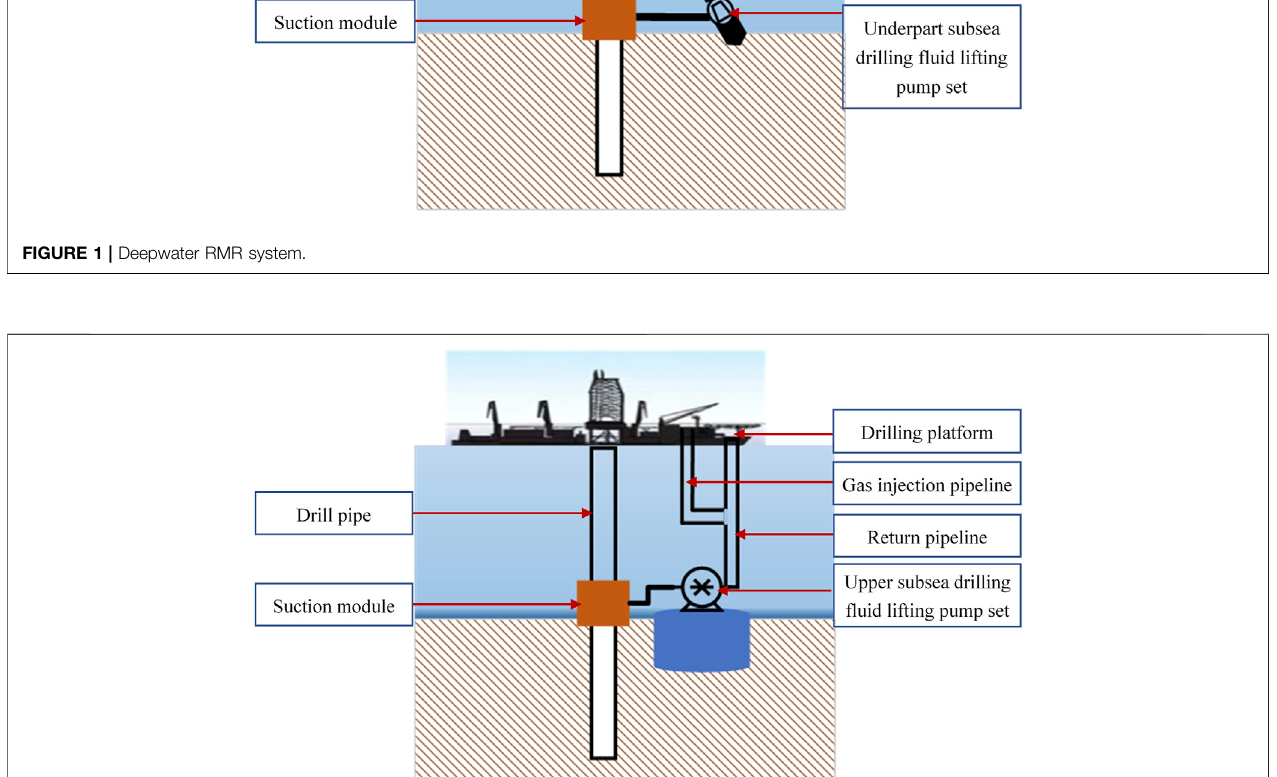
FIGURE 2 | Schematic of the gas + pump combined lifting